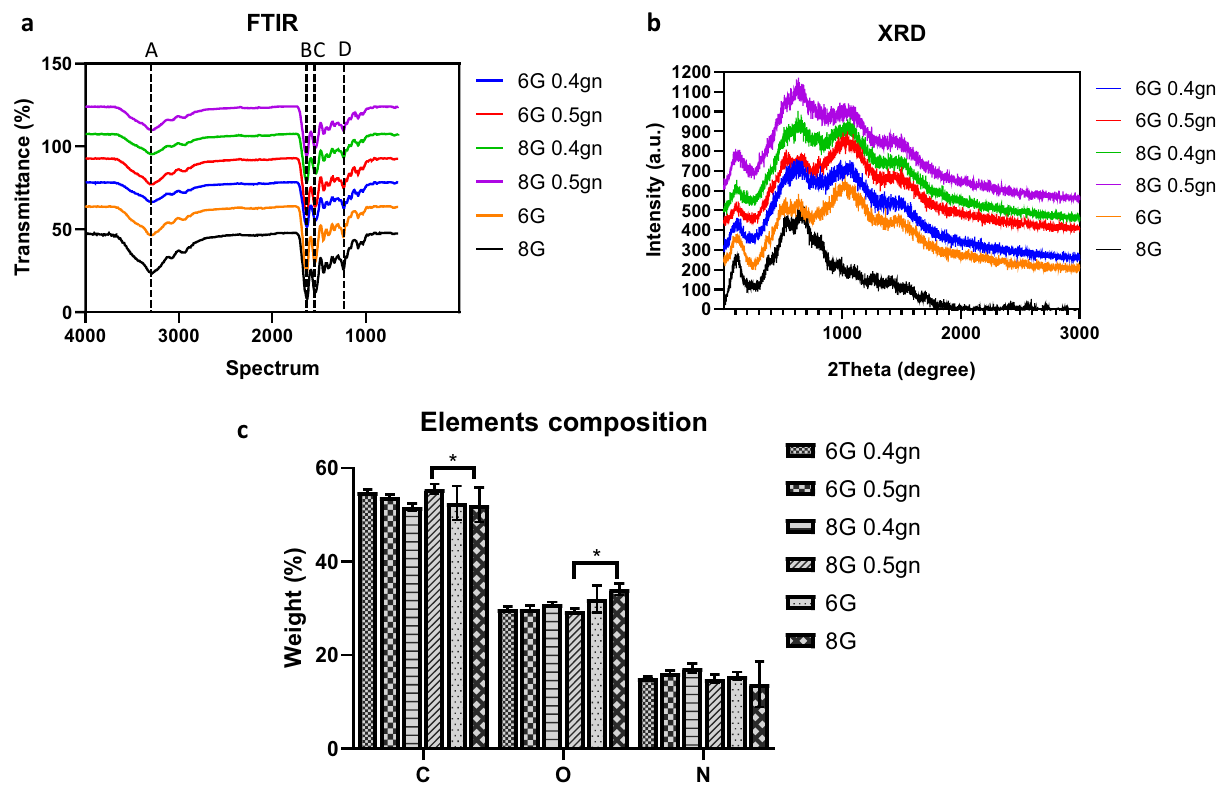
Figure 3. Chemical analysis of genipin-crosslinked gelatin hydrogels (* p < 0.05). ( a ) FTIR spectrum of the genipin-crosslinked and non-crosslinked gelatin hydrogels. ( b ) XRD spectrum of the genipin-crosslinked and non-crosslinked gelatin hydrogels. ( c ) Element distribution of carbon, oxygen and nitrogen in the genipin- crosslinked and non-crosslinked gelatin hydrogels.